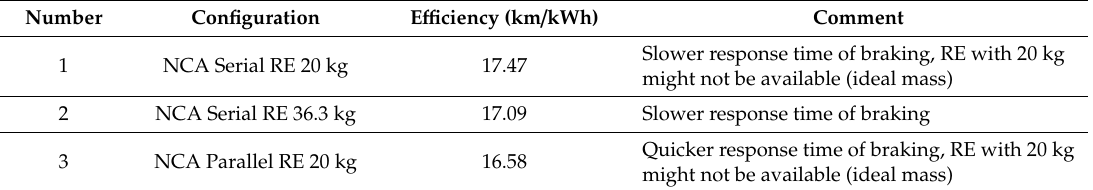
Table 11. E ff ective and most e ffi cient configuration for the complete